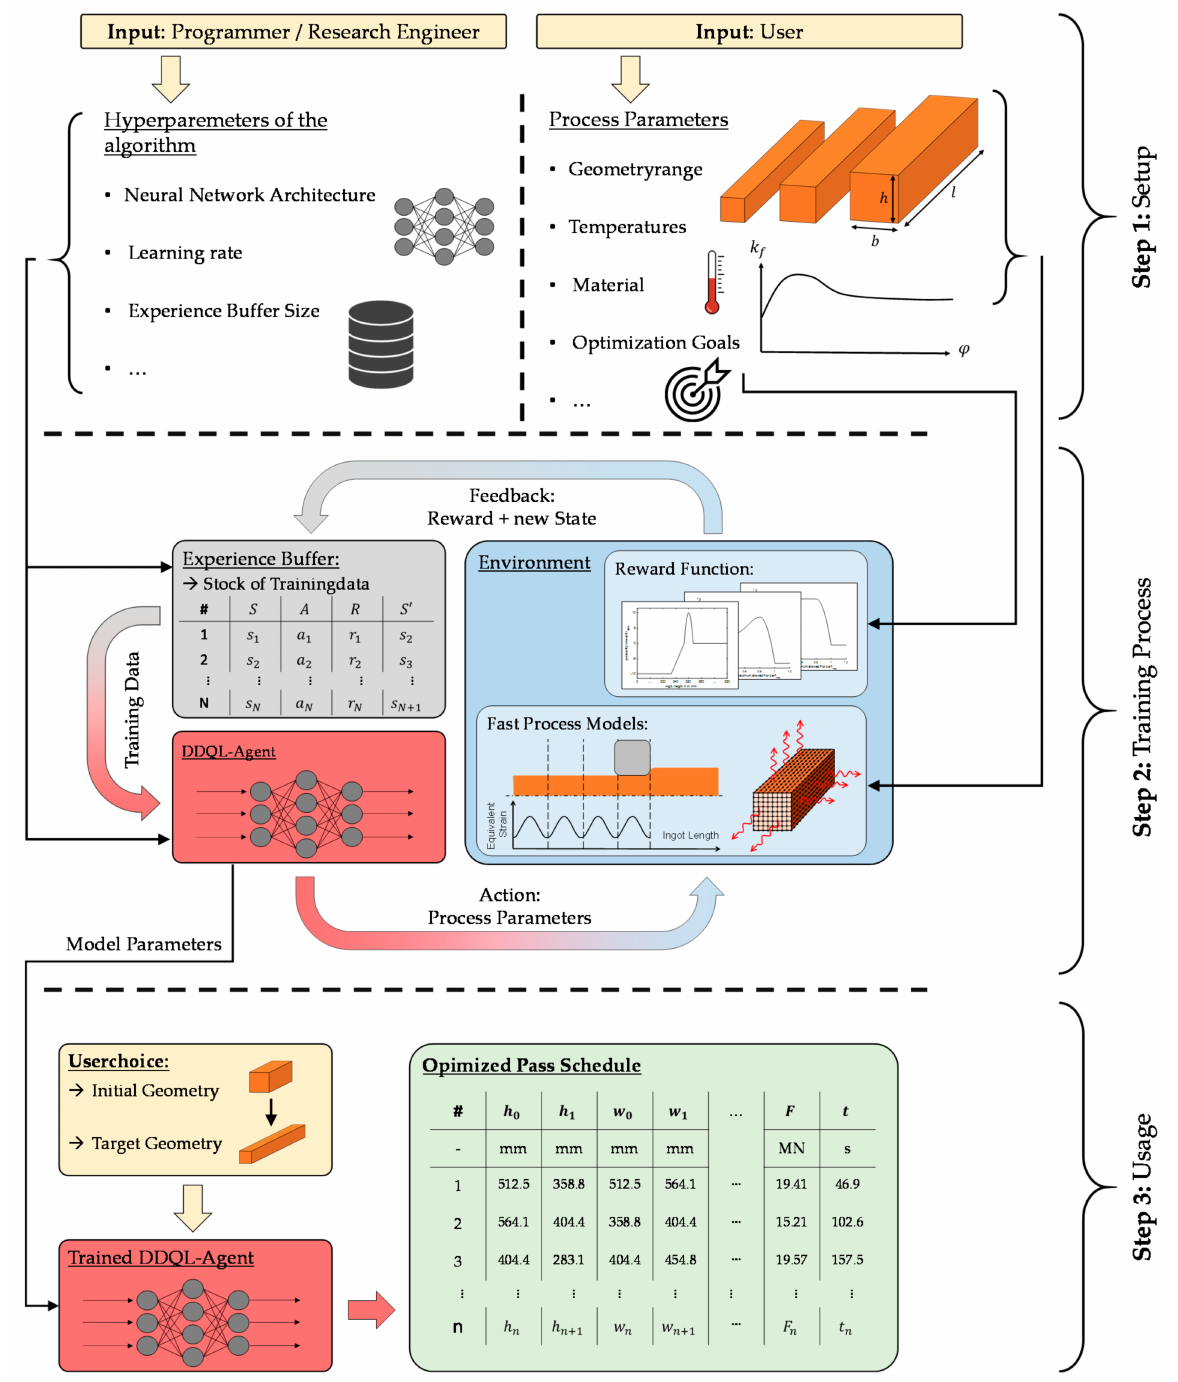
Figure 7. Application cycle of the implemented DDQL